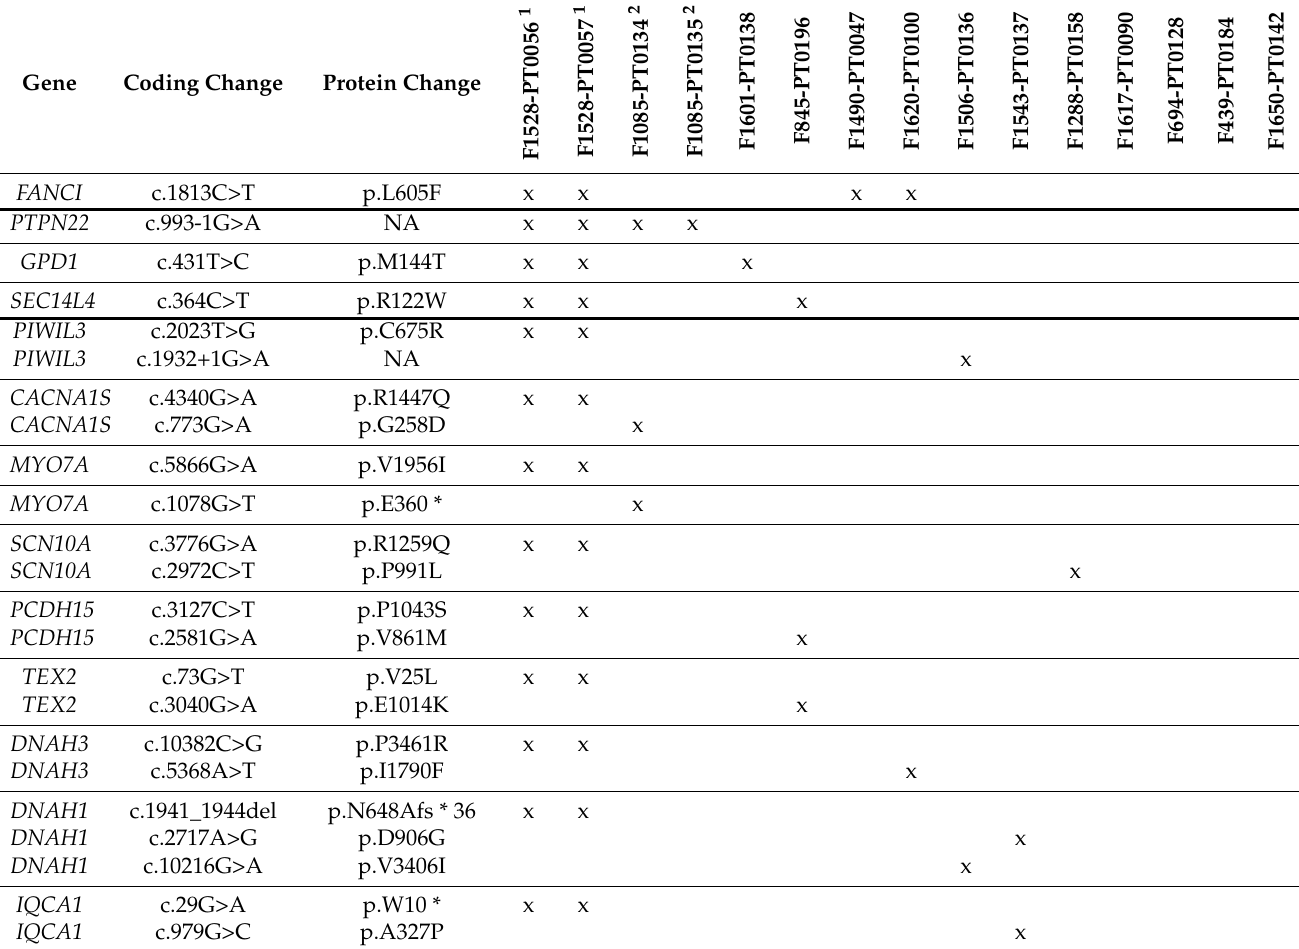
Table 1. Genetic landscape variants and other variants identified in genes where genetic landscape variants were identified in OC cases of FC ancestry negative for pathogenic variants in BRCA1 , BRCA2 , BRIP1 , RAD51C , and RAD51D , including FANCI c.1813C>T carrier